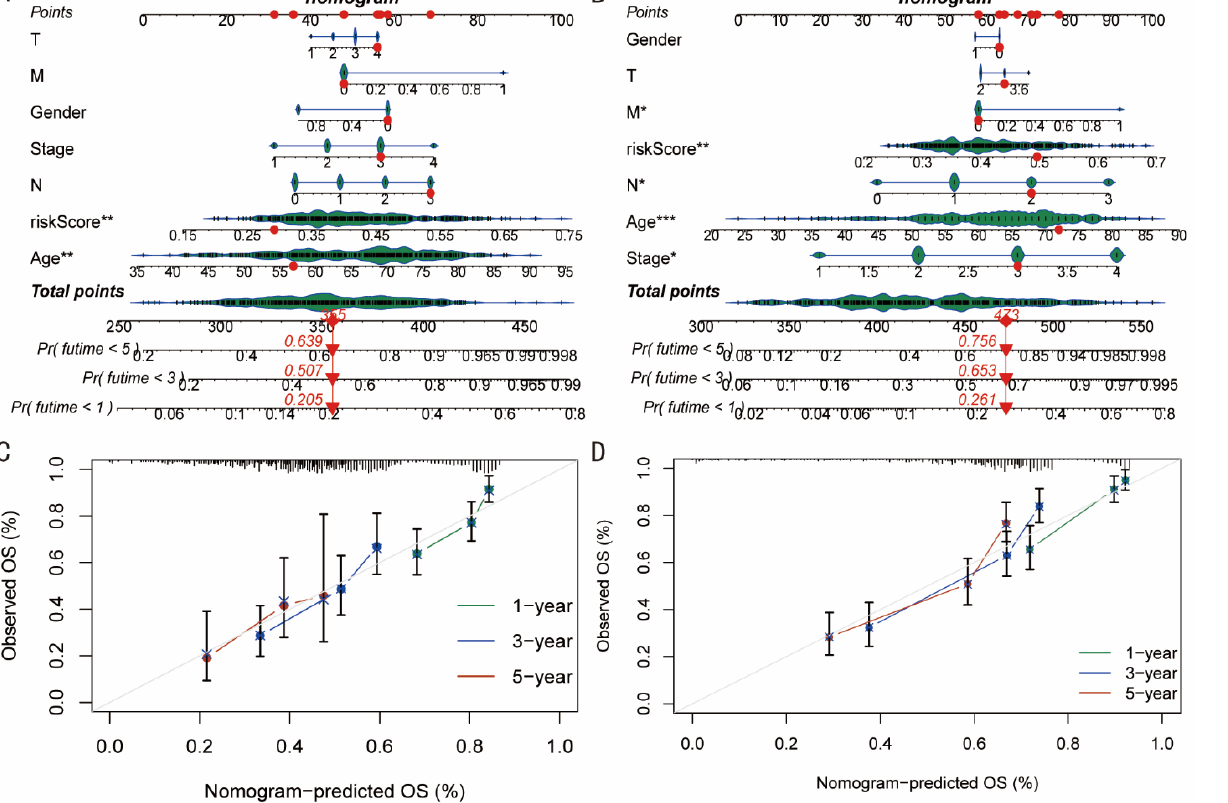
Figure 6. Conducting nomograms. ( A , B ) RiskScore and age were associated with the prognosis of patients with GC, and nomograms were conducted. * 0.05; ** 0.01; *** 0.001. ( C , D ) Nomogram-pre- dicted OS at 1, 3, and 5 years were conducted. ( E , F ) The AUC at 1, 3, and 5 years were calculated.